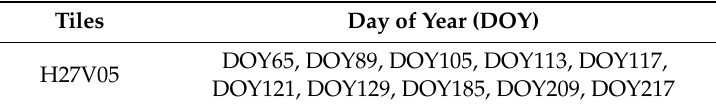
Table 3. Information of MOD09A1 and GLASS FVC used in this study.